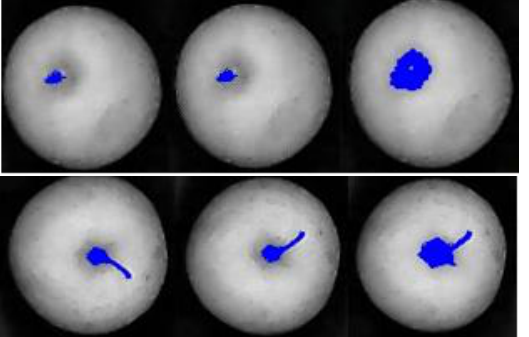
Figure 8. Results of stem/calyx segmentation by clustering ( left ), inter-variance ( middle ), and Niblack ( right ) thresholding approaches.